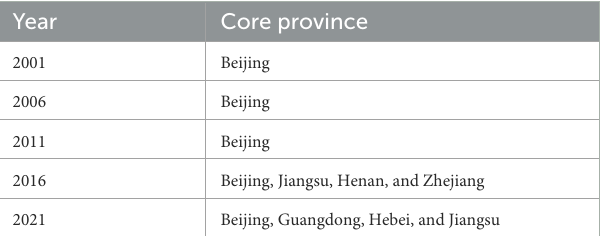
Table 8. From 2001 to 2021, Beijing held the top spot in China’s low- carbon patent cooperation network in terms of coreness.